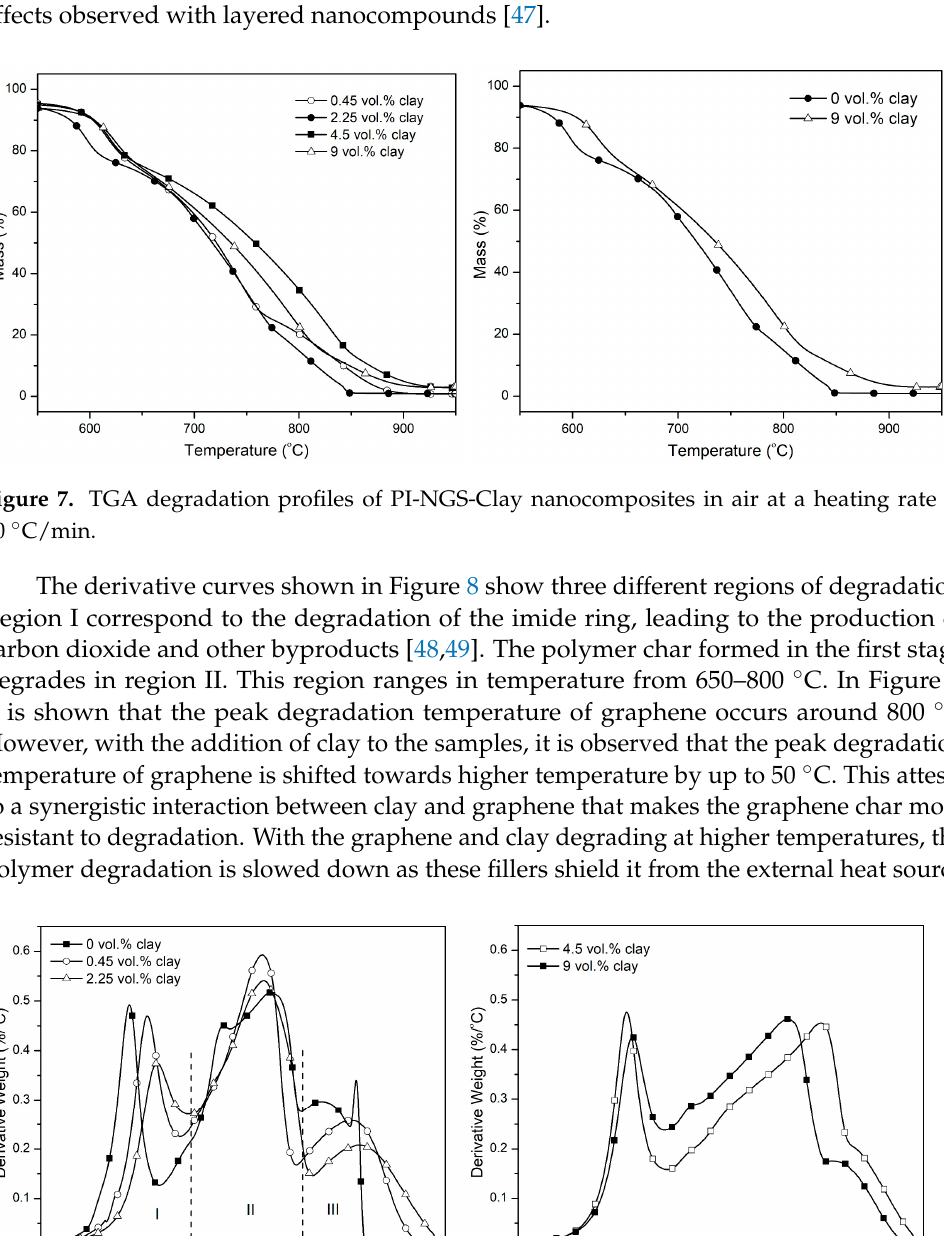
Figure 6. Graph showing the TGA degradation profiles for polyimide, Cloisite 30B organomodified